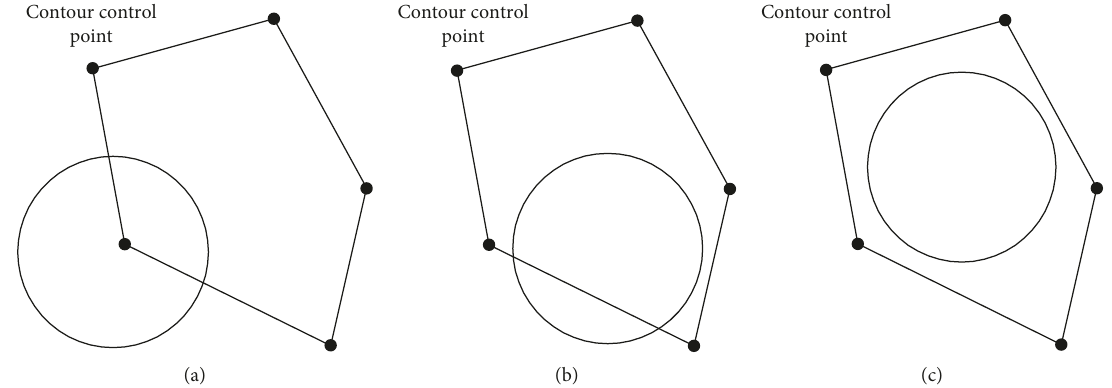
Figure 4: Polygons-circumcircle conflict and overlap criteria. (a) Control point inside circle. (b) Polygonal edges intersect with circle. (c) Circle inside the polygon.